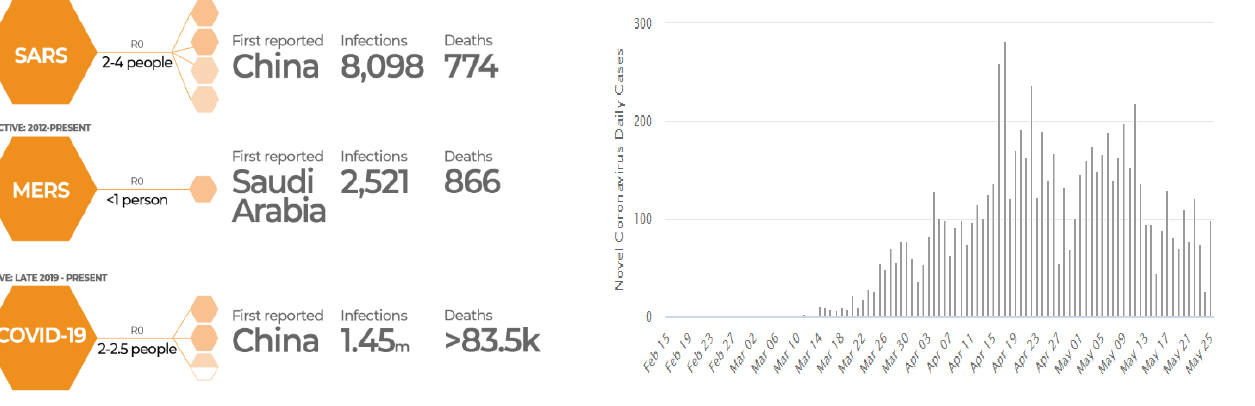
Figure 3 : Morocco daily new cases (From Feb 15 to May 25